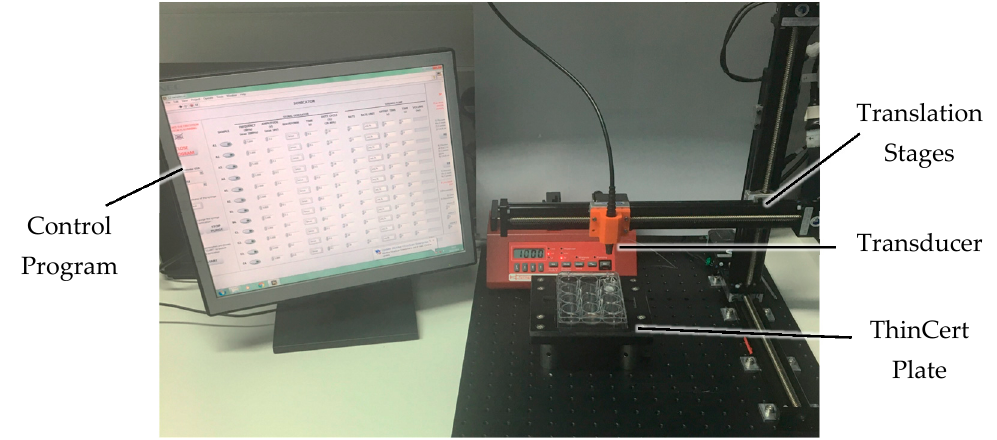
Figure 9. Insonation system comprising three axis translation stages, syringe pump, signal generator (off screen), cell plate holder, control program, and miniature focused US transducer.